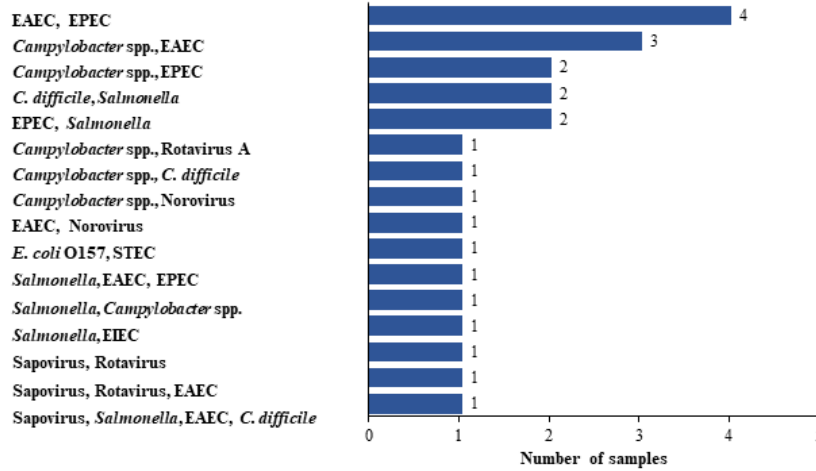
Figure 2. Coinfections detected in GIP-positive specimens. Among the 61 positive stool samples, 24 samples were positive for more than one pathogen (i.e., coinfection), with various combinations of pathogens, as presented in the graph.